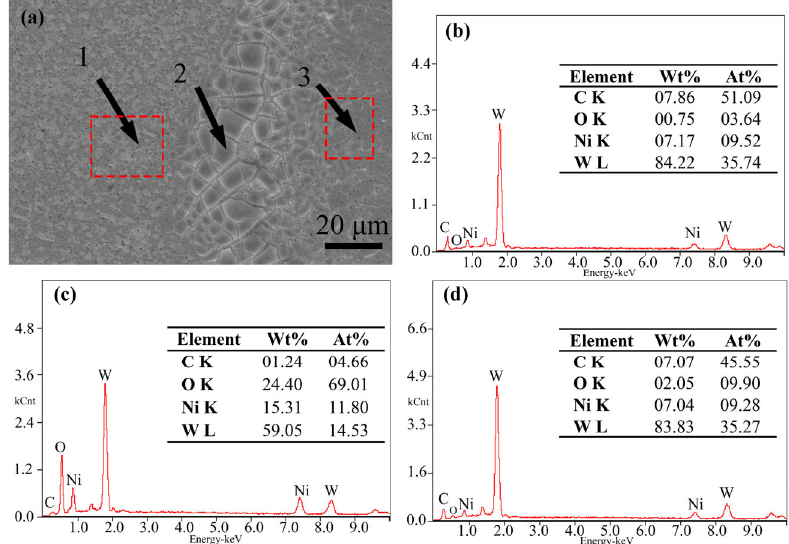
Fig. 8 Detailed investigation of irradiated YN6 surfaces following tribo-tests, (a) SEM image of irradiated YN6 surface following friction, (b) − (d) EDX spectrum of marked regions 1 − 3 in (a),